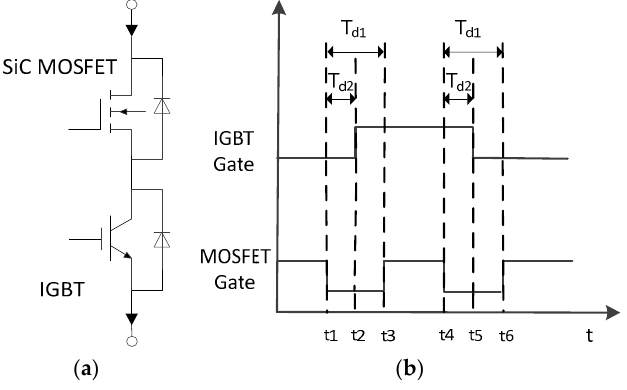
Figure 2. ( a ) Proposed Hybrid Switches Configuration; and, ( b ) Modulation.